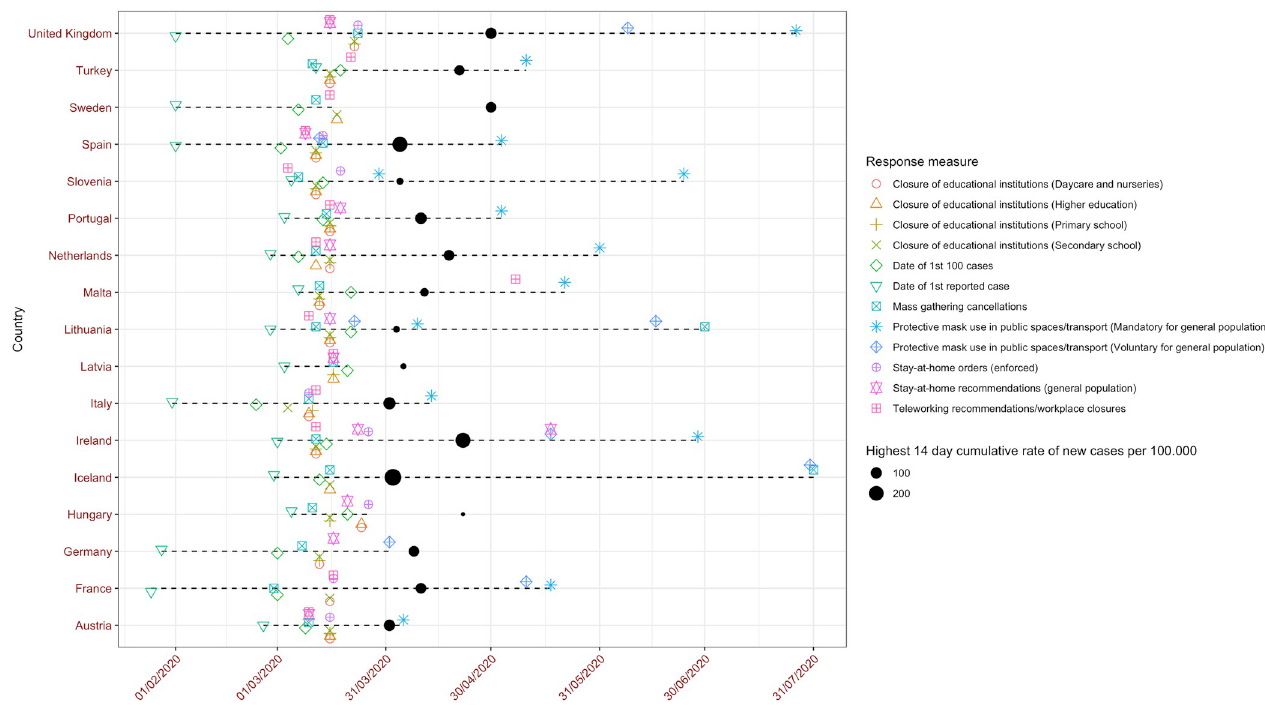
Fig 1. Timelines of first phase of COVID-19 pandemic in participating countries. Timelines of the introduction of national infection prevention measures (“Response measures”), as well as dates for the first and first 100 cases of SARS-CoV-2 for each of the countries participating in the EPISODES study. The black circle depicts the date of the highest 14-day cumulative rate of new SARS-CoV-2 cases per 100,000, with the size reflecting the actual case rate. COVID-19, Coronavirus Disease 2019; EPISODES, Epidemiology, severity and outcomes of children presenting to emergency departments across Europe during the SARS-CoV-2 pandemic; SARS-CoV-2, Severe Acute Respiratory Syndrome Coronavirus 2.